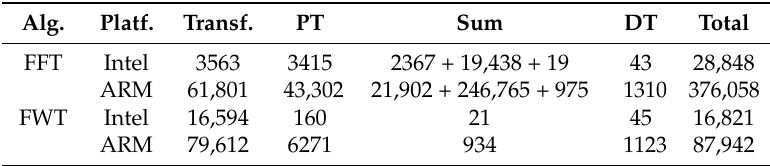
Table 3. Compositions of the execution time for different platforms. All values are average values obtained from 1000 runs, and are in ns. Alg. Platf.